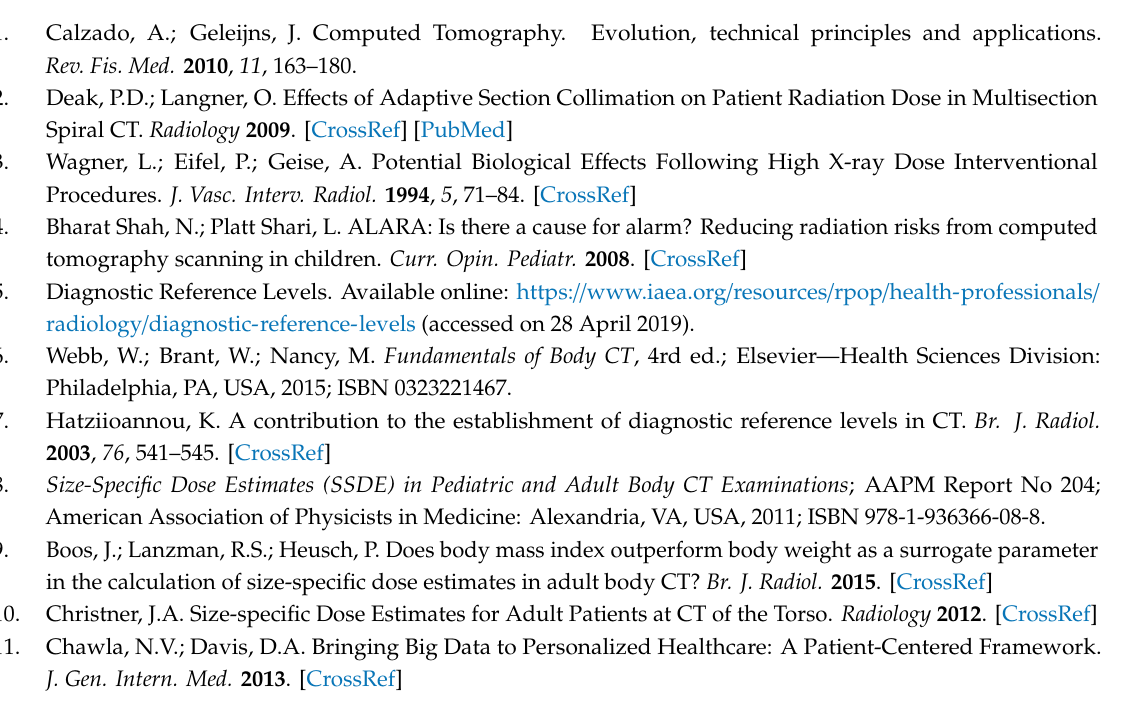
Supplementary File 1: Description of Machine Learning Techniques and Supplementary File 2: Results involving ML, protocols, and dose